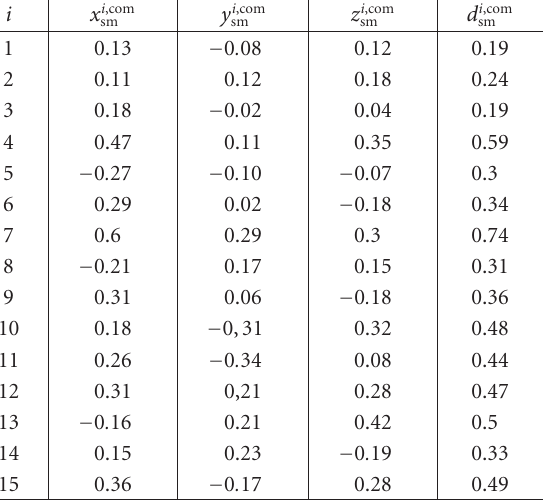
Table 2: First positioning test results. The i -ball labels are those of Figure 6 (all values are given in millimeters).